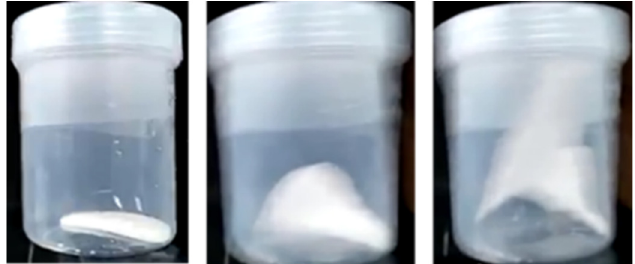
Figure 1. Pictures of the climbing colloidal suspension of 70 wt. % silica particles of 1.0 µ m diameter with water under horizontal vibration. The corresponding movie is given in Supplementary Materials. The left picture shows the suspension at rest, and the middle (~8 s in the movie) and right (~12 s in the movie) ones are under